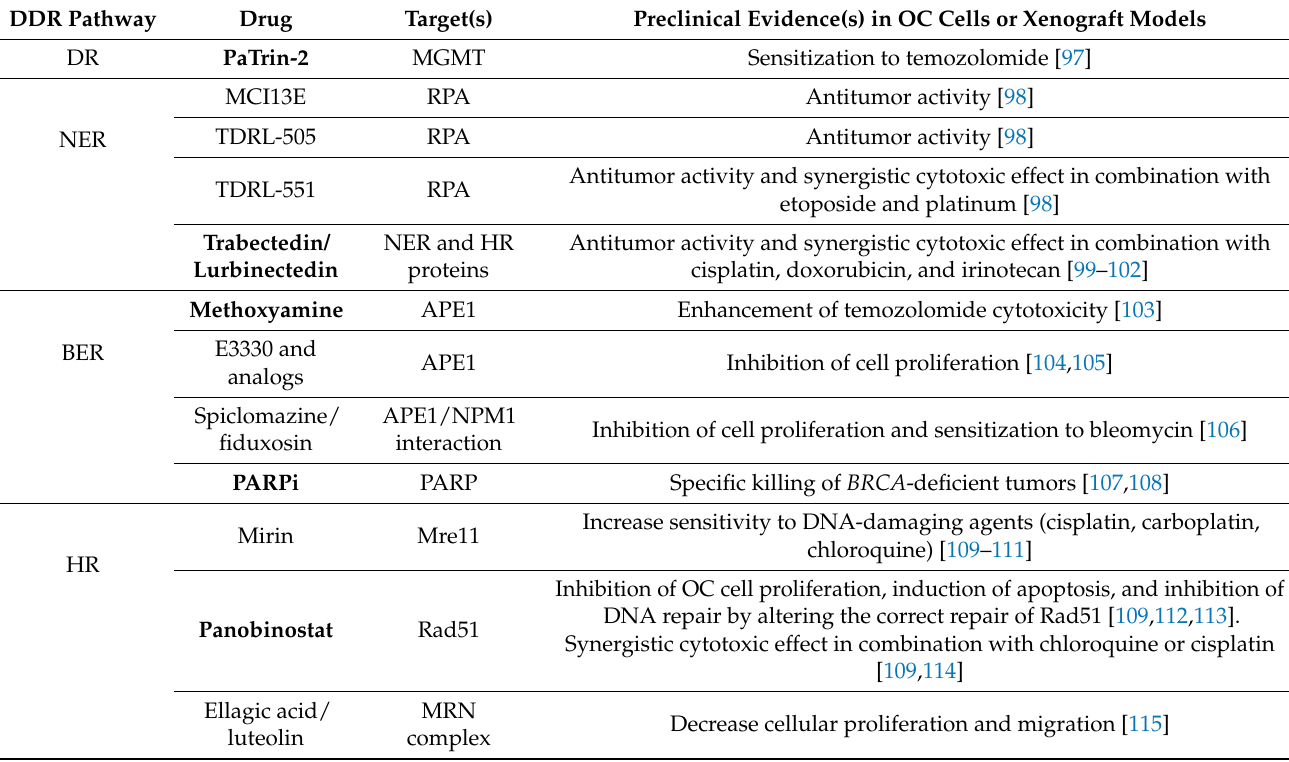
Table 4. DDR-targeting drugs investigated in preclinical